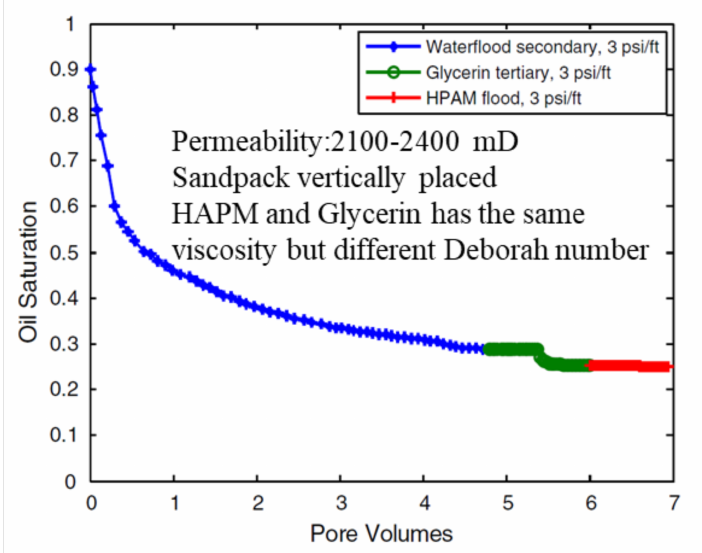
Figure 5. Polymer effect on residual oil saturation (revised after